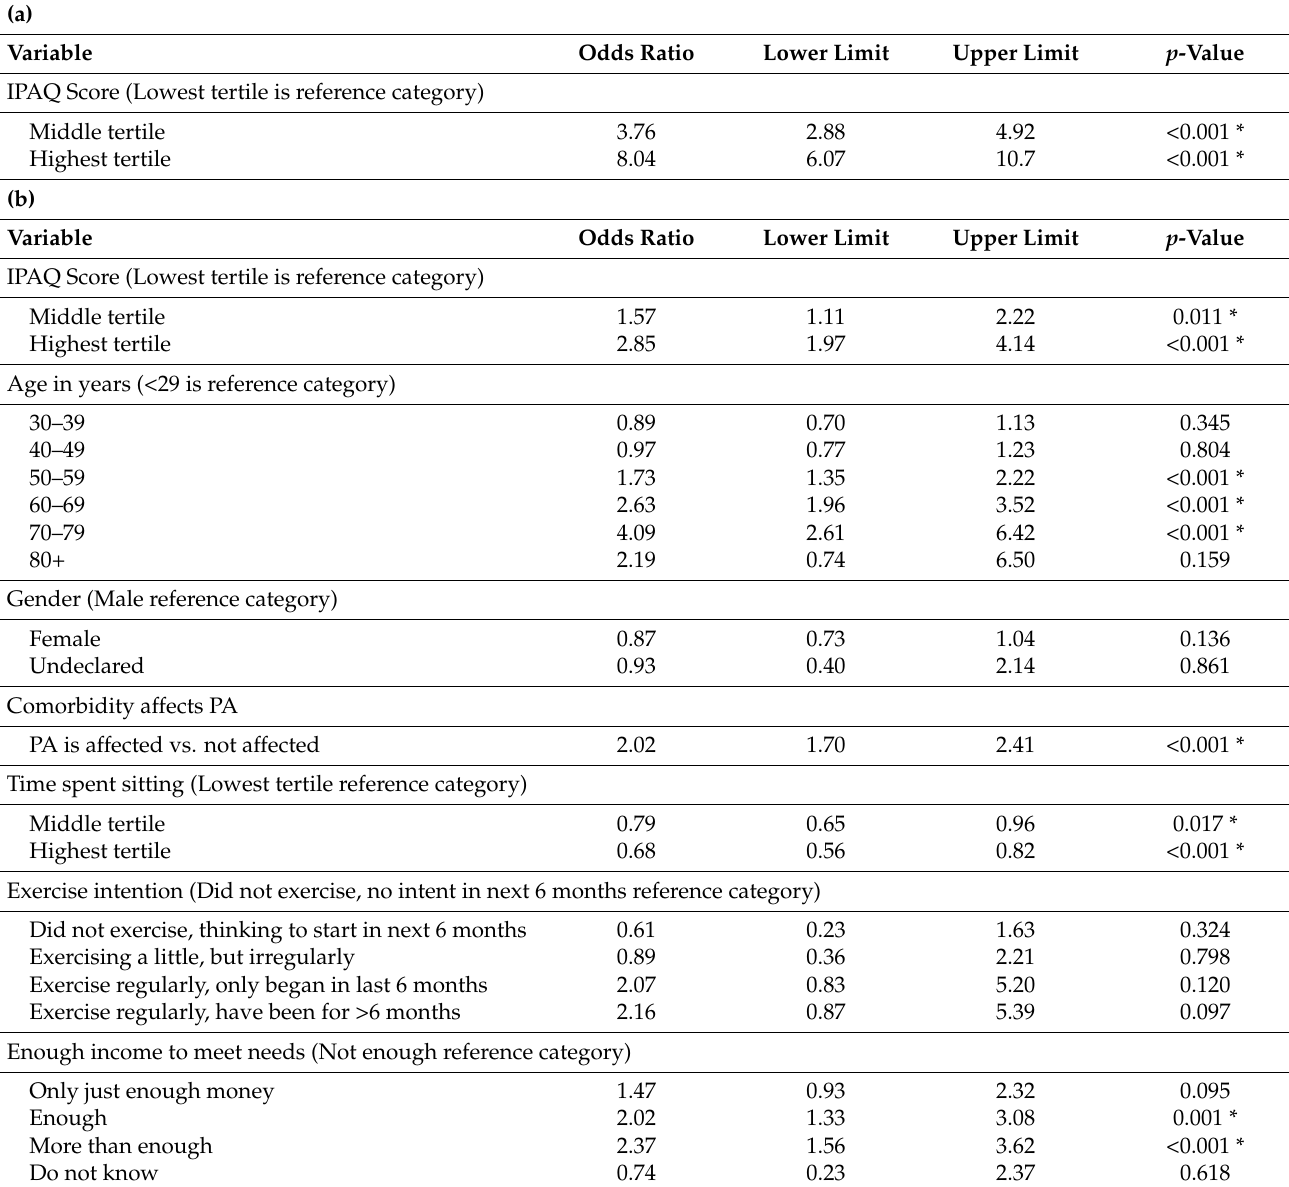
Table 2. ( a ). Single variable logistic regression model where binarised WHO-5 score regressed on tertiles of IPAQ score (crude odds ratio). ( b ). Multivariate logistic regression model of binarised WHO-5 score on IPAQ scores after adjusting for age, gender, comorbid conditions affecting ability to be physically active, sedentary behaviour (time spent sitting), intention to exercise, and perceived income